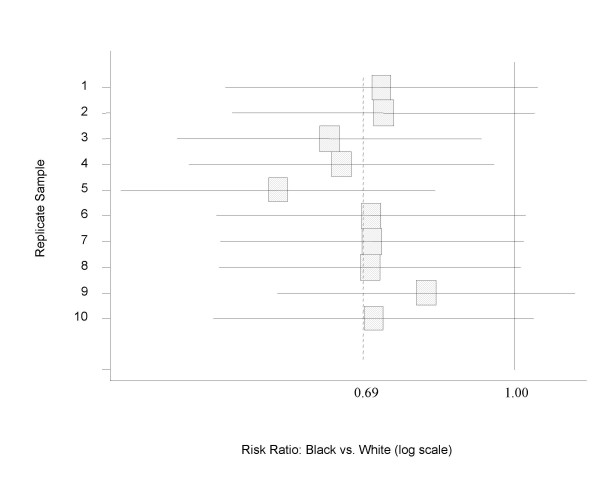
Results of regression analysis for race with the dependent variable obtaining blood cultures prior to initial antibiotic dose. Forest plot demonstrating the results of the 10 individual conditional logistic regressions models for the dependent variable blood cultures obtained prior to initial antibiotic dose after adjusting for severity of illness using the PSI. The presented relative risk with 95% confidence intervals is for the independent variable race (dichotomized into black versus white).